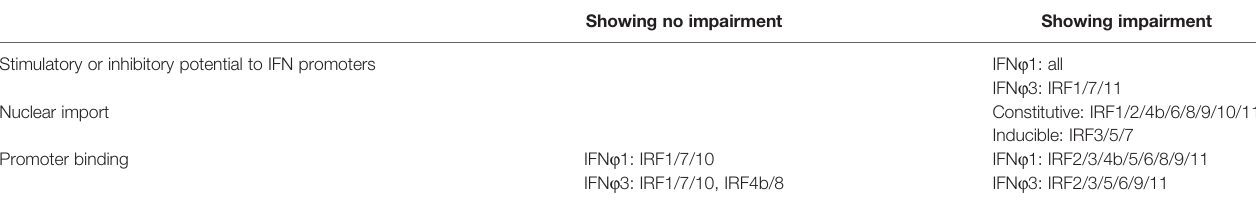
TABLE 2 | Impairment of zebra fi sh IRF mutants on promoter activation, nuclear import and DNA binding.